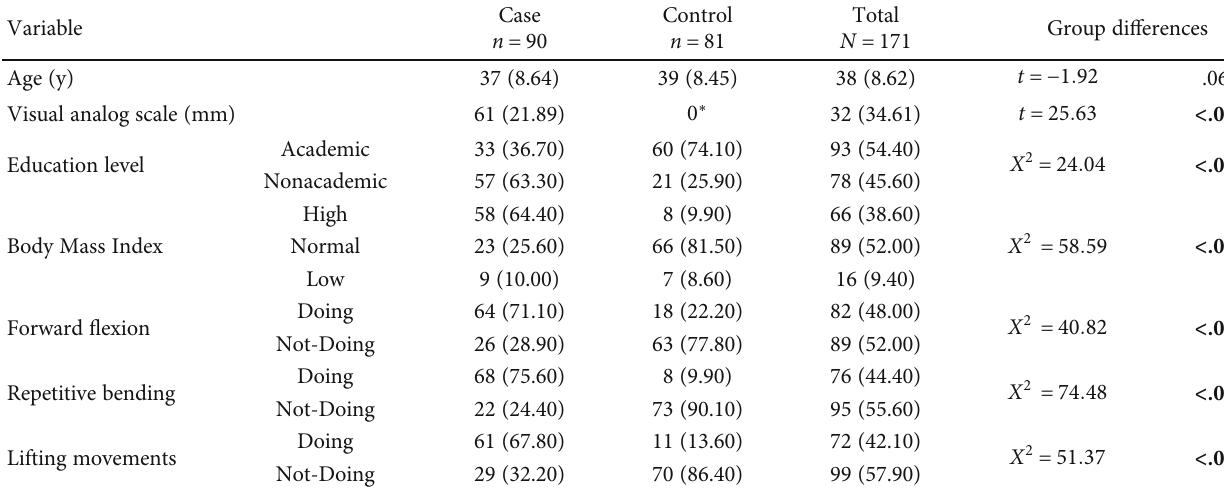
Table 1: Comparing mean (standard deviation) and frequency ( % ) of the demographic and clinical assessments.